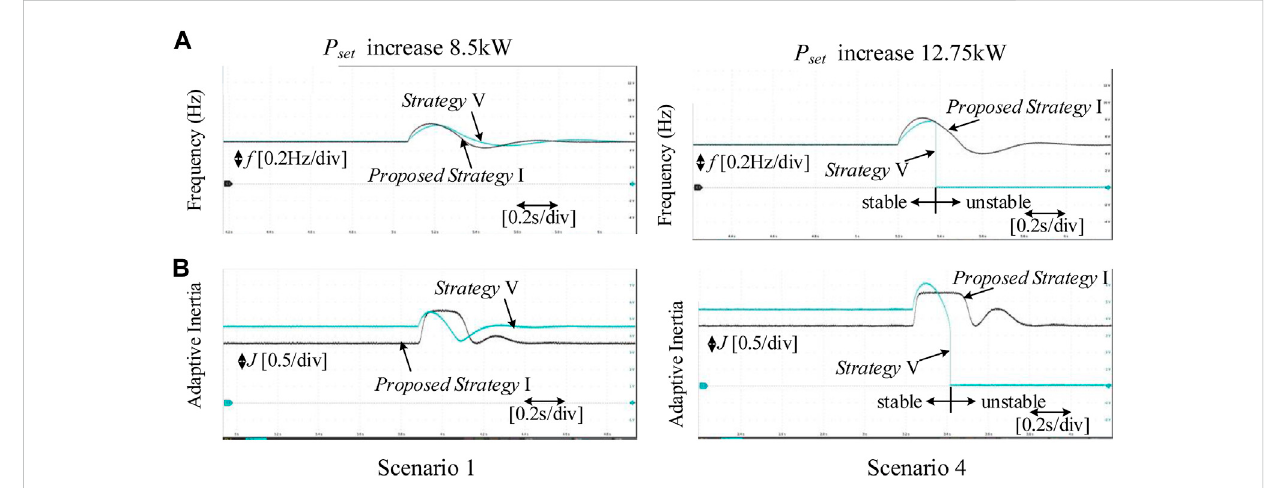
FIGURE 13 Experimental results of Scenarios 1 and 4. (A) Frequency of GFM inverter. (B) Inertia of GFM inverter.